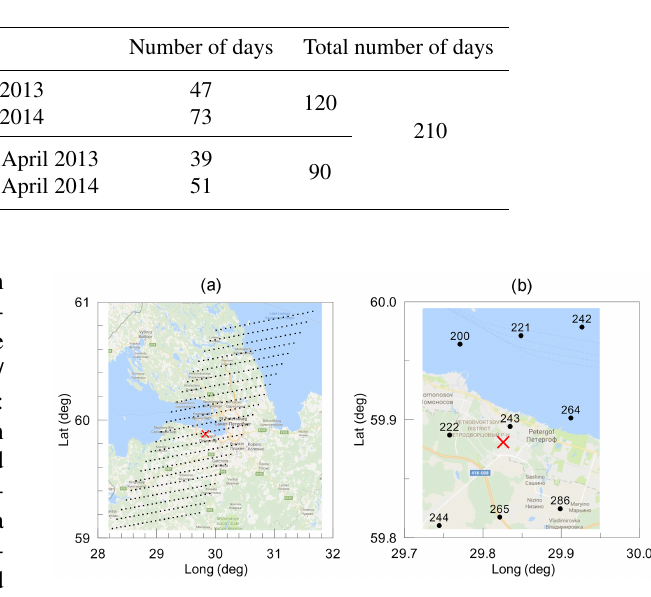
Table 2. Seasonal periods for comparison of HATPRO and SEVIRI data.